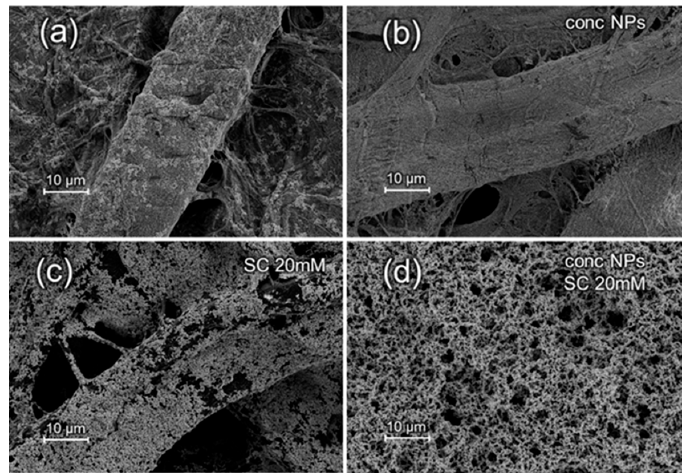
Figure 2. FE-SEM images with the same magnification (5 k) of Au NPs, as prepared ( a , c ) or 10× concentrated (“conc NPs”) ( b , d ), loaded on filter paper (average pore size: 2 µ m) in absence ( a , b ) or presence ( c , d ) of 20 mM sodium citrate